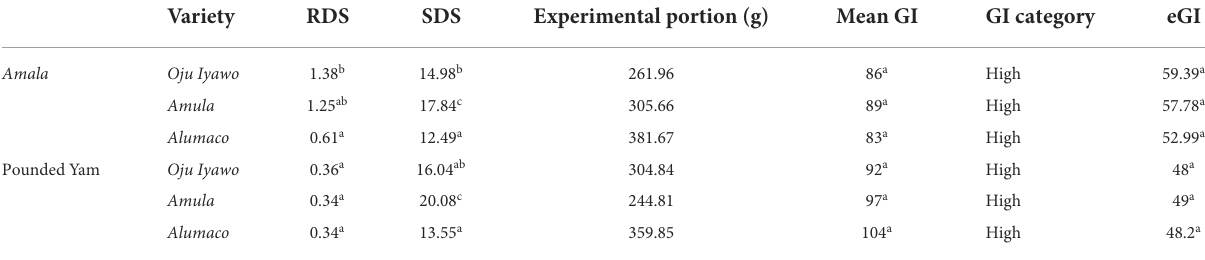
TABLE 2 * Rapidly Digestible Starch (RDS), Slowly Digestible Starch (SDS) and GI values in Amala and Pounded Yam made from Yam (g/100g). Variety RDS SDS Experimental portion (g) Mean GI GI category